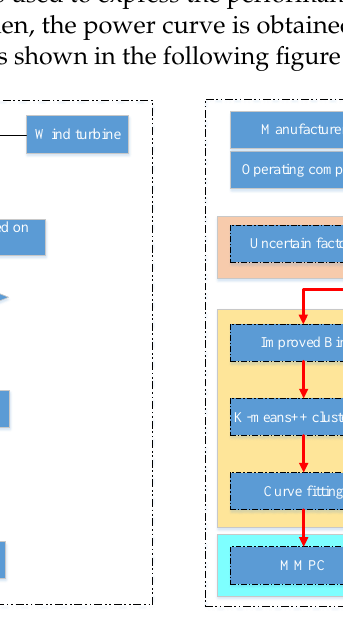
Figure 5. Flow chart of curve modify.